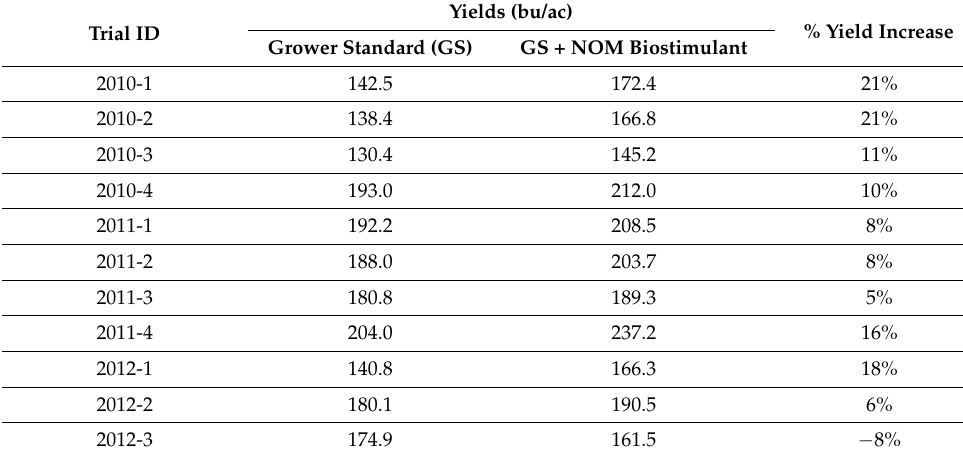
Table 1. Yields for the 2010–2012 Nebraska corn field trials, where abiotic stress occurred in the field. Additional trial details are given in Supplementary Table